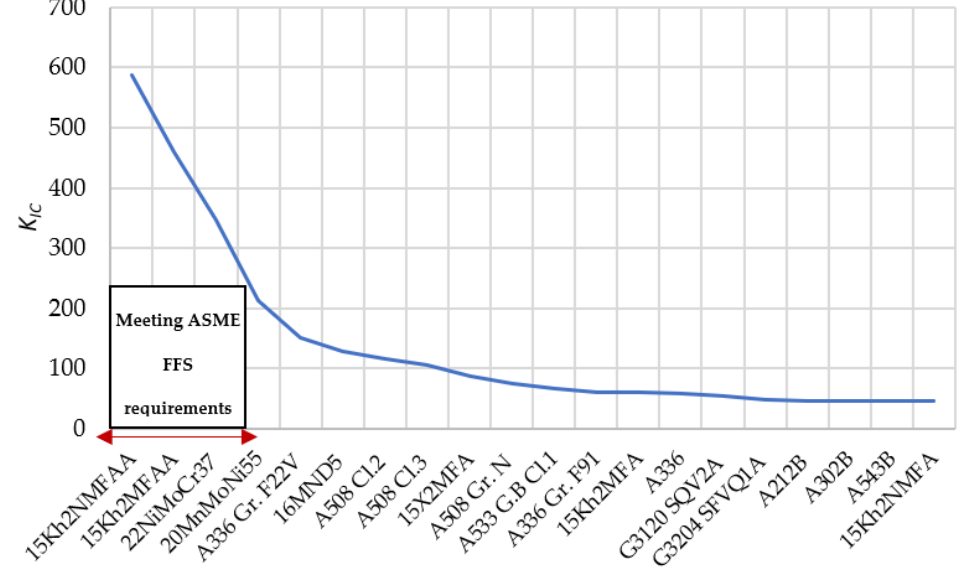
Figure 7. K IC for the materials analyzed.